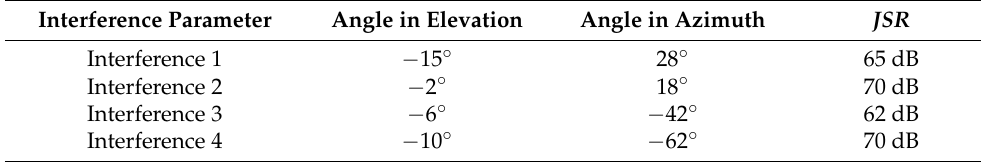
Table 4. Interference parameters.